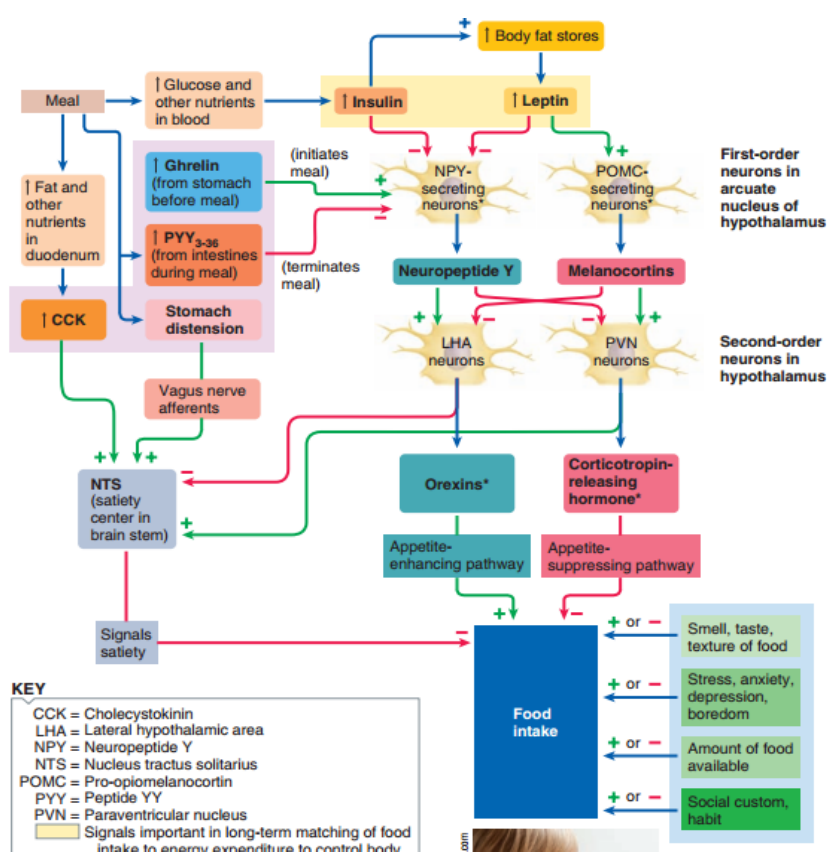
Figure 2 . Factors that influence food intake Figure explanation: CCK: Cholecystokinin, LHA: Lateral hypothalamic area, NPY: Neuropeptide Y, NTS: Nucleus tractus solitaries, POMC: Pro-opiomelanocortin, PYY: Peptide YY, PVN: Paraventricular